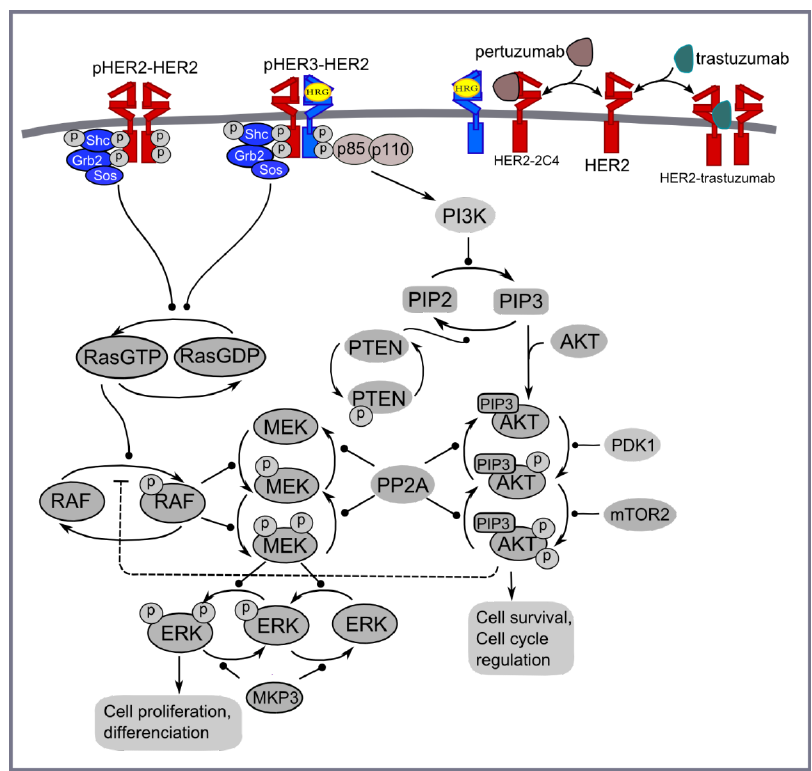
Figure 4. PI3K/AKT and ERK1/2 pathways activated by homo- and heterodimerisation of HER2 and HER3 receptors in the presence of HER3 ligand (HRG) and HER2 inhibitors: trastuzumab and